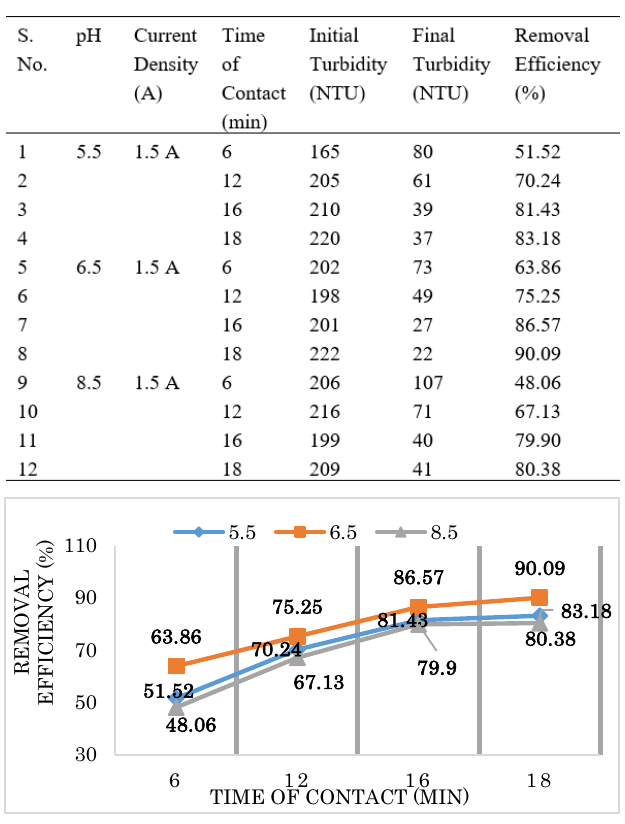
Fig. 3. Time optimization for turbidity removal for 1.5 A